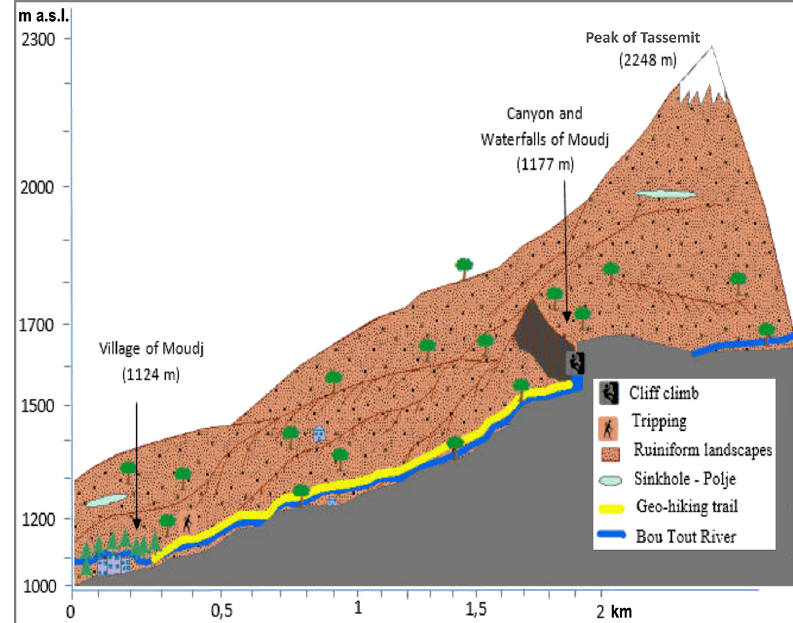
Fig. 13. Moudj canon geo-hiking